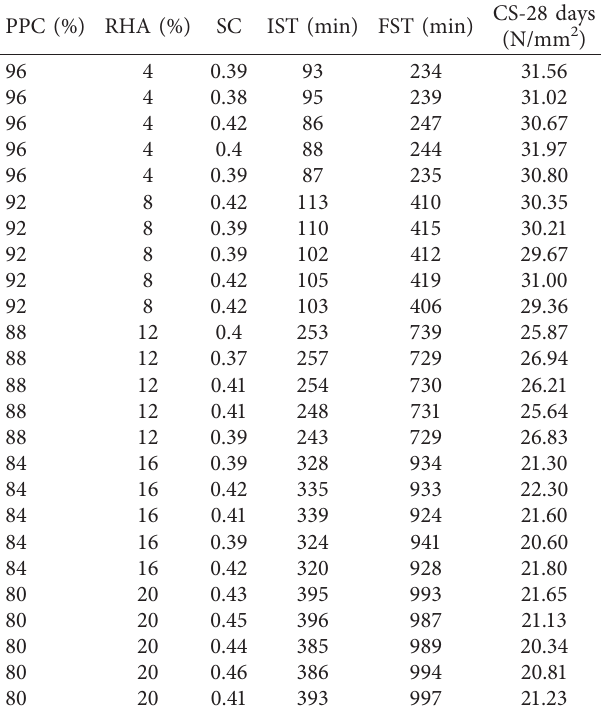
Table 2: Training dataset for ANN2-RHA replacement.